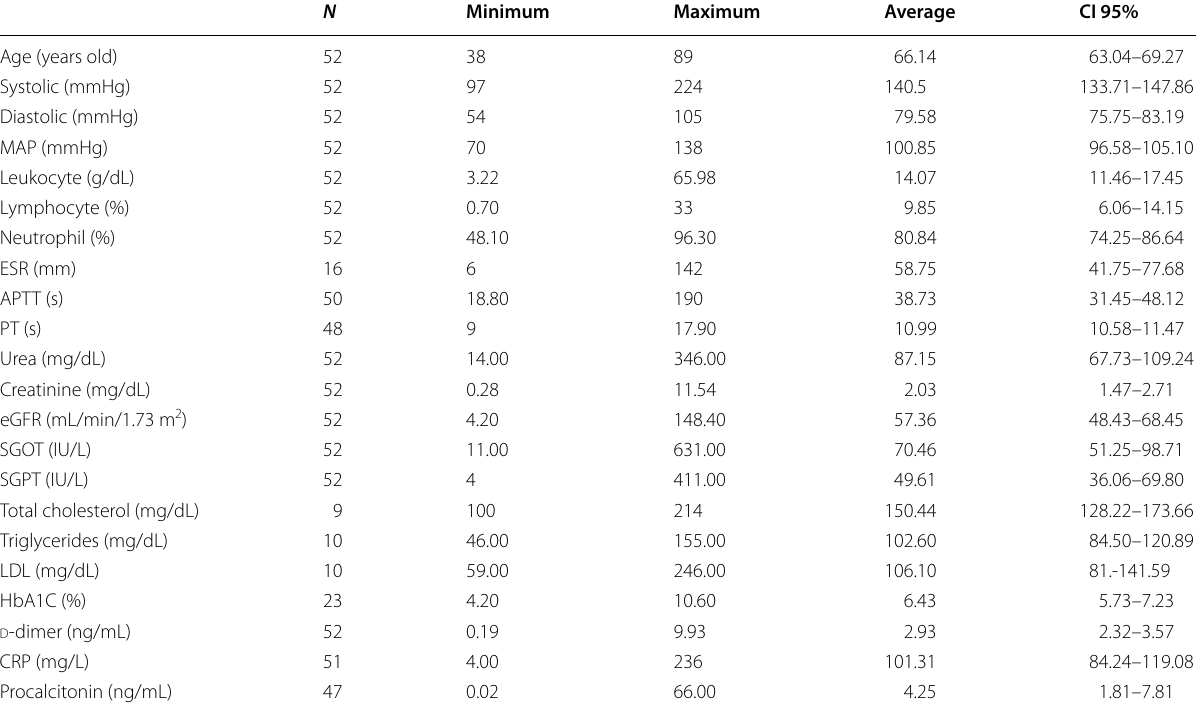
Table 2 The clinical, laboratory data of the patients and the 95% confidence